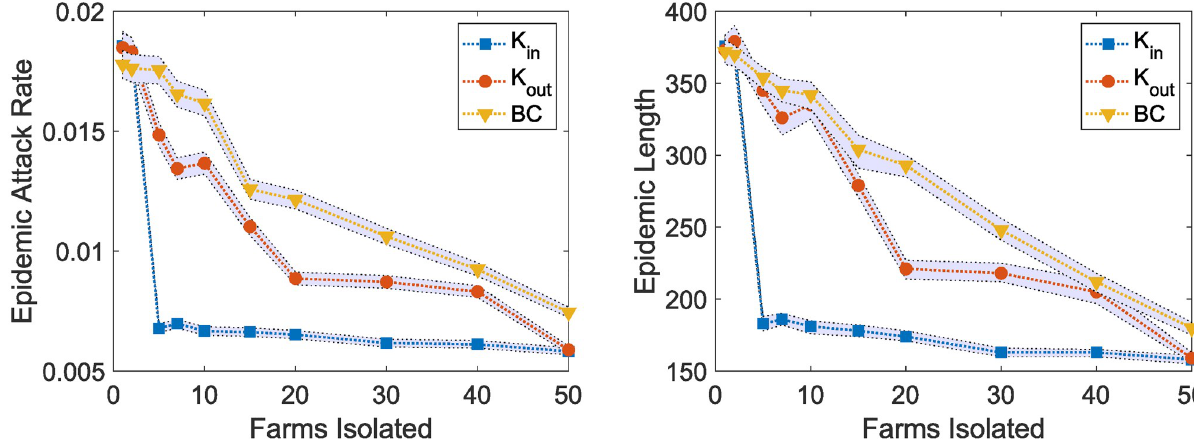
Fig 6. Comparison of different targeted isolation schemes based on farm node centrality measures. Three different movement restriction strategies (high in degree, K in , high out degree, K out , and high betweenness, BC ) are compared. For each strategy, different number of farms are isolated from a centrality based sorted descending list. The left plot shows the epidemic attack rates and the right plot shows the epidemic lengths. The data points are mean values computed from 10,000 stochastic simulations and the shaded regions show 95% confidence intervals.